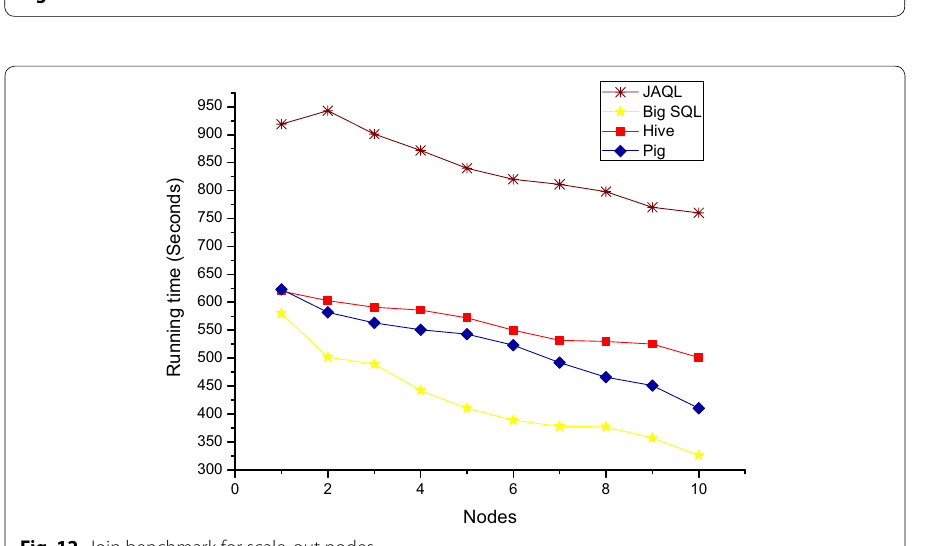
Fig. 12 Join benchmark for scale‑out